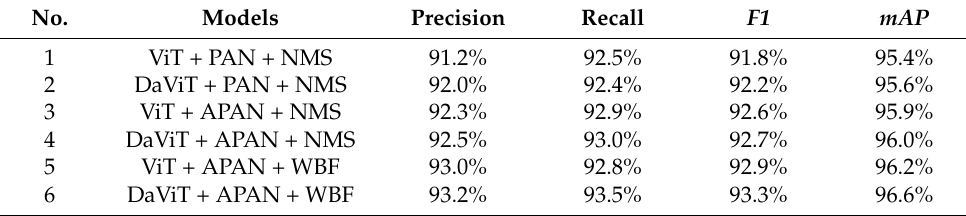
Table 6. Ablation experimental results on the NWPU VHR-10